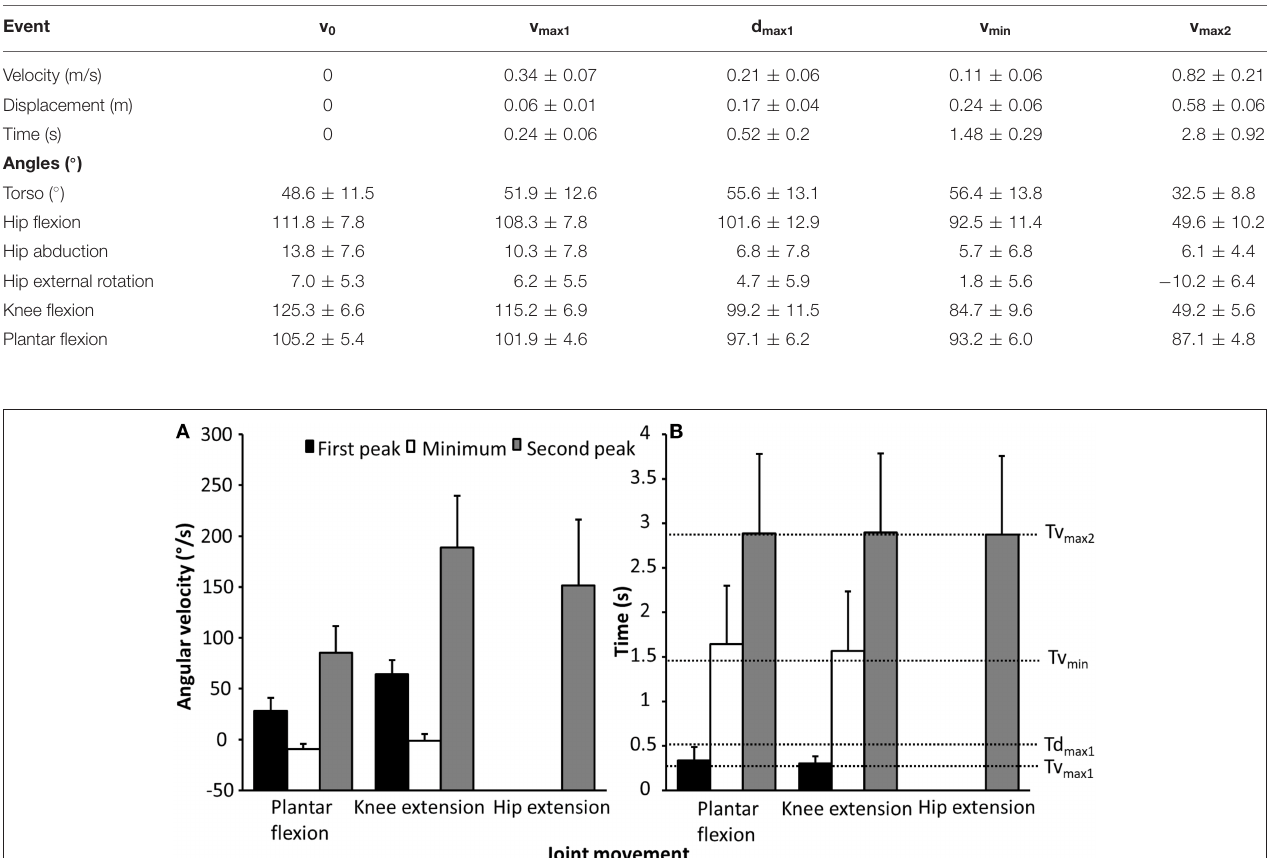
FIGURE 2 | Mean ± SD (A) first and second peak and minimum angular velocity of the plantar flexion, knee, and hip extension, (B) timing of the first and second peak, and minimum angular velocity of the plantar flexion, knee, and hip extension during the last repetition in 3-RM back squats.